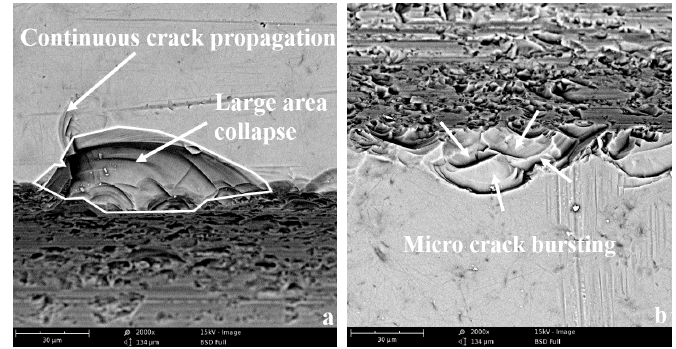
Figure 10. The comparison of material removal mode: ( a ) conventional sawing; ( b ) ultrasonic sawing.